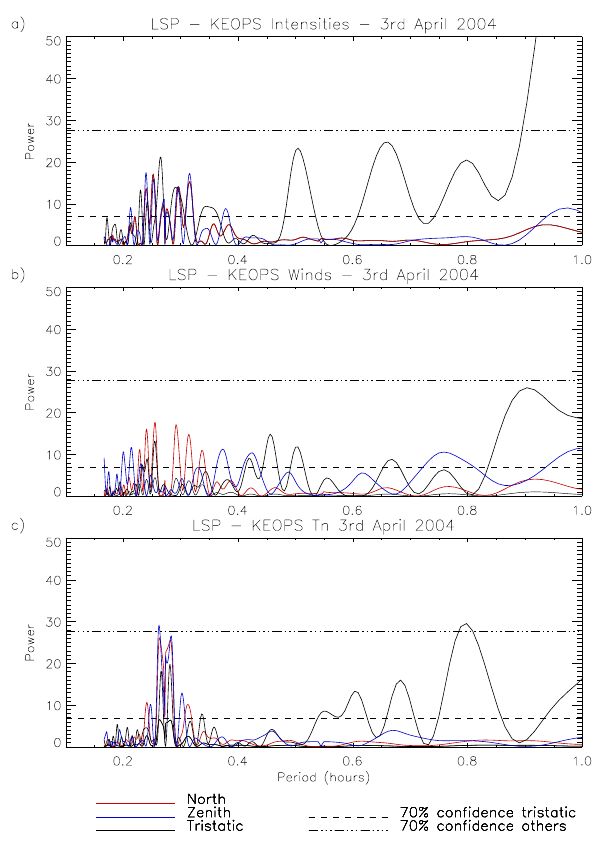
Fig. 7. Lomb-Scargle Periodogram up to periods of 1h, from KEOPS data on 3 April 2004: (a) intensities, (b) winds, and (c) temperatures. The low resolution look directions are scaled by a factor of 4.